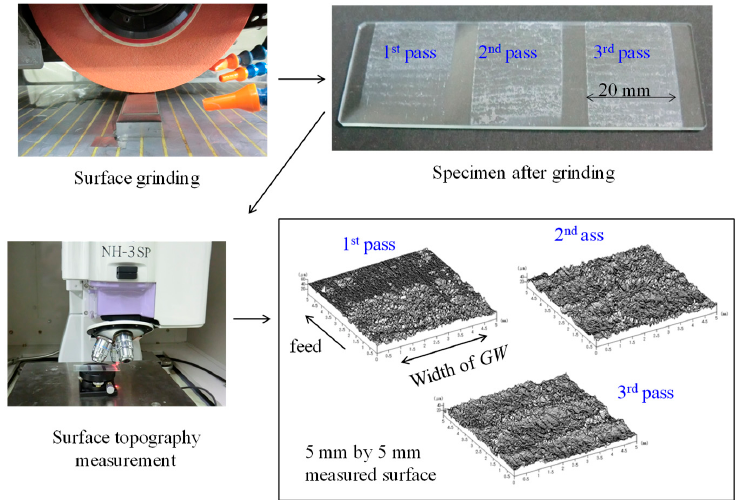
Figure 2. Results of a preliminary experiment.